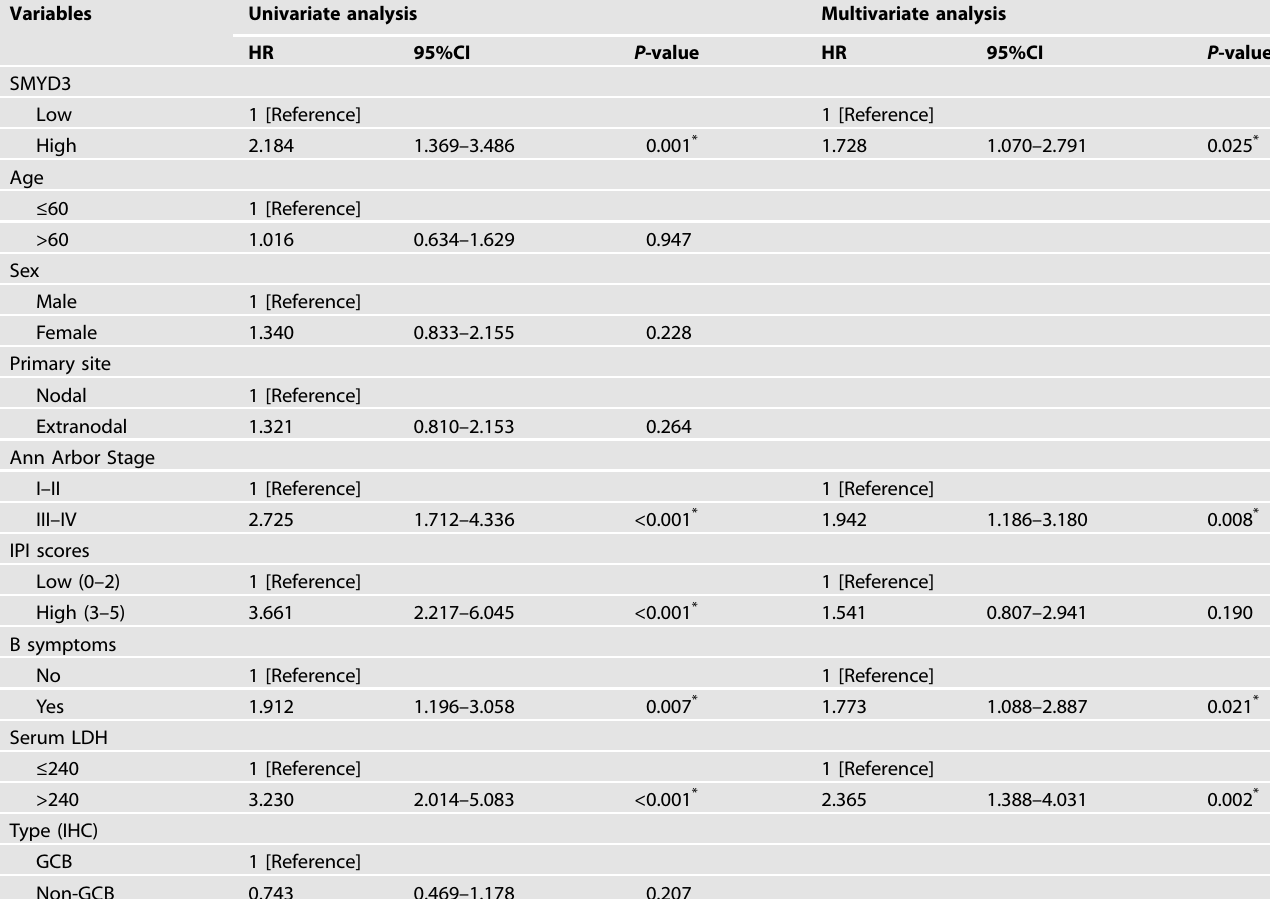
Table 2. Univariate and multivariate analysis for associations of SMYD3 protein expression with PFS in DLBCLs.